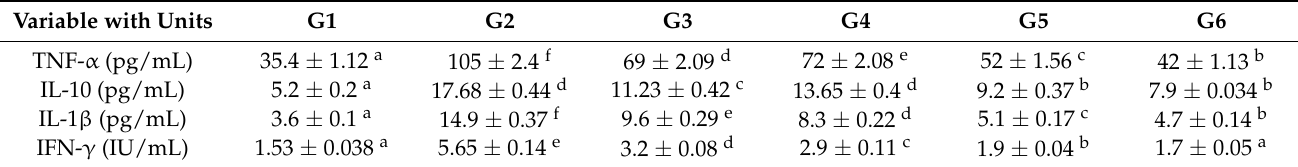
Table 2. Effect of Spirulina maxima extract, Lactobacillus casei ATCC 7469-fermented wheat bran extract and their combination on inflammation markers in Sprague–Dawley rats at 7